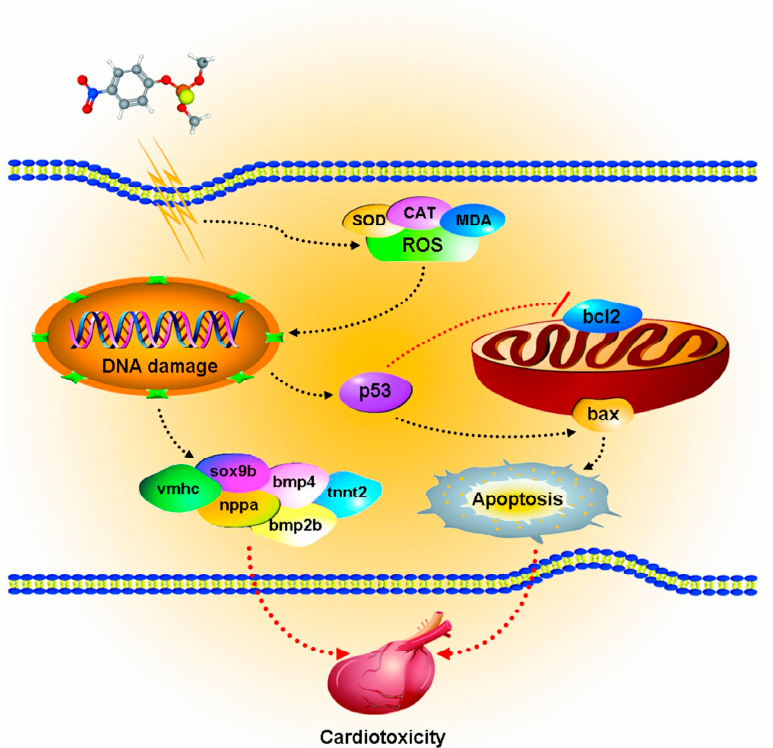
Figure 7. Potential mechanisms of cardiotoxicity in zebrafish exposed to methyl parathion. The apoptotic pathway induced by methyl parathion exposure in zebrafish embryonic cells disrupts the balance of oxidative and antioxidant systems, leading to ROS accumulation and DNA damage.